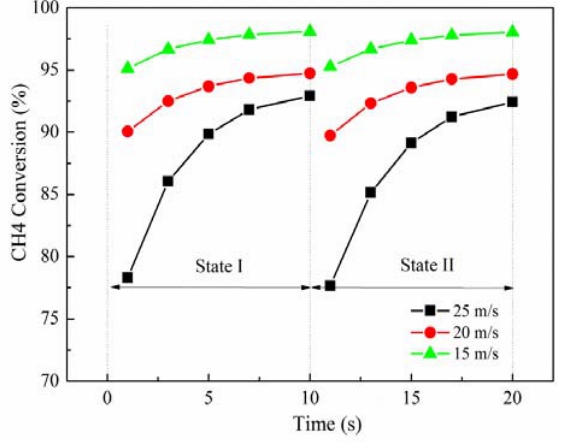
Figure 2. The effect of inlet velocities on the methane conversion rate; C in , ch4 = 2%.